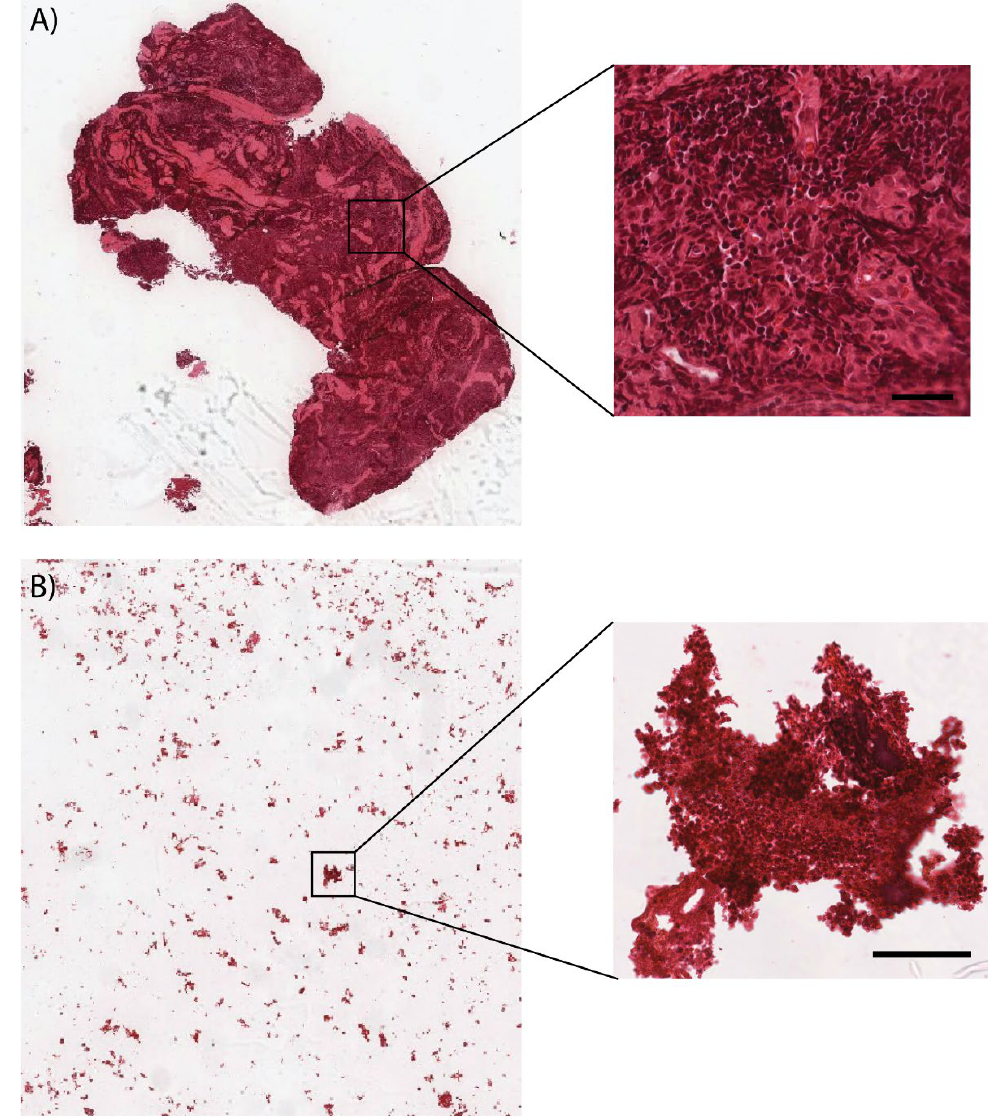
Figure 1. Microscopic image of pleural fluid of adenocarcinoma ( A ) and the tissue of squamous cell carcinoma ( B ) (×100, ×400, scale bar 50 μm). carcinoma ( B ) ( × 100, × 400, scale bar 50 µ